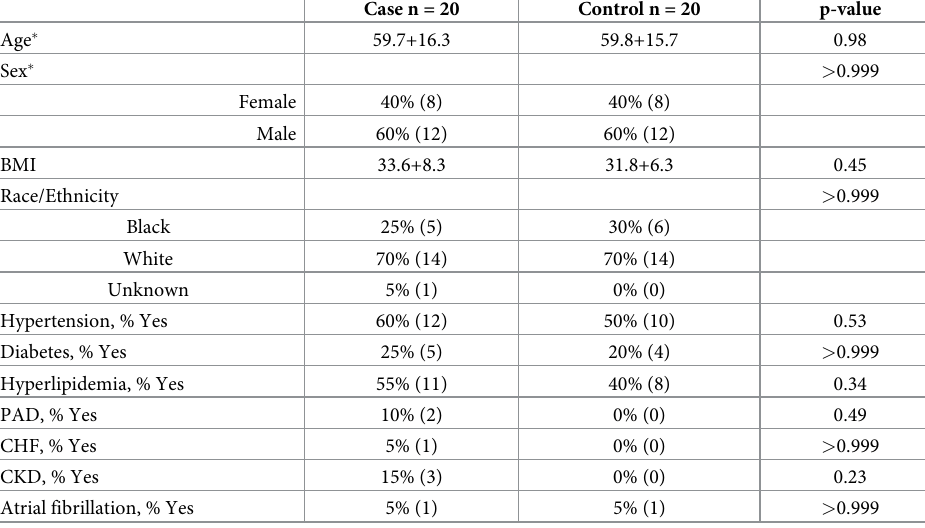
Table 1. Demographic and clinical